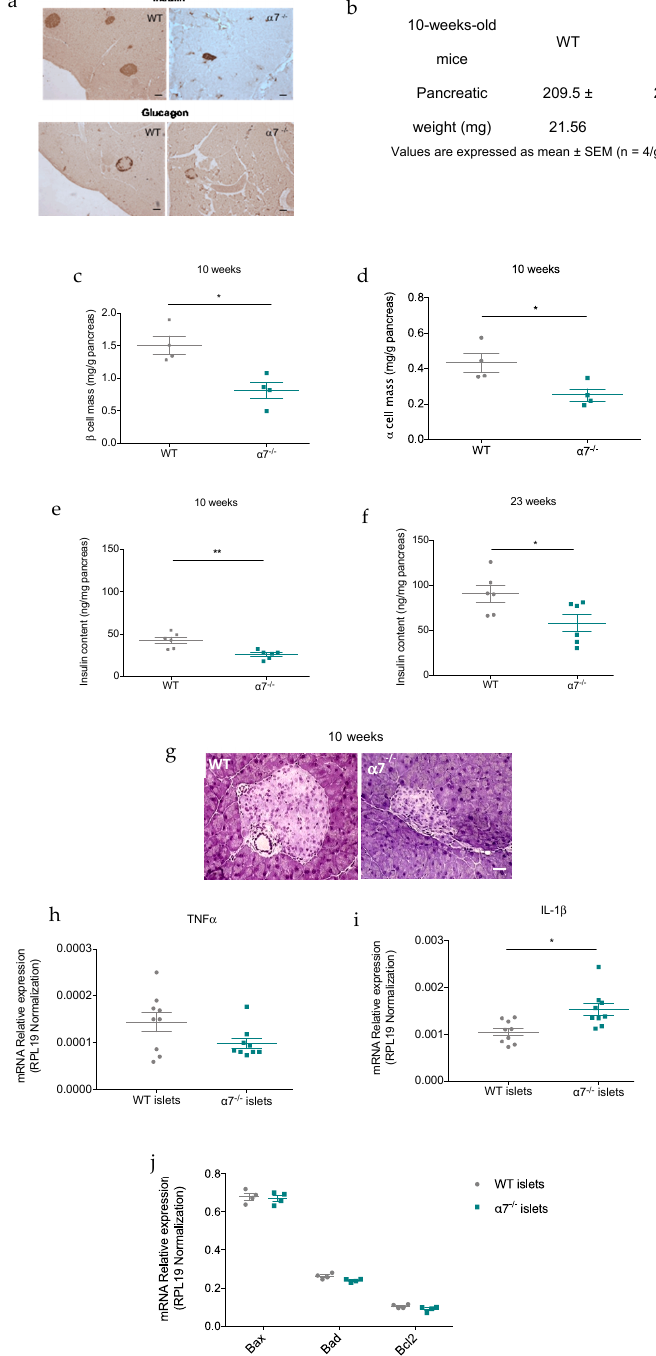
Figure 4. α 7 nAChR deficiency is associated with a reduction in β -cell mass in mice. Pancreata were harvested from 10-week-old male α 7 − / − and WT control mice. α -and β -cell mass were measured by morphometric analysis after glucagon or insulin immunostaining. Illustrative images of